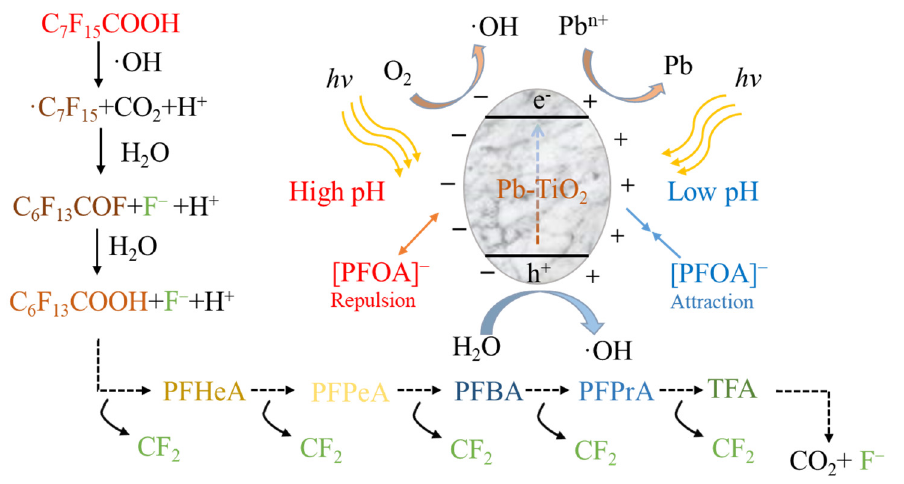
Figure 2. Photocatalytic pathways of PFOA decomposition. Reprinted with permission from Ref. Ref. [110]. 2016, Chen, M.-J.; Lo, S.-L.; Lee, Y.-C.; Kuo, J.; Wu,